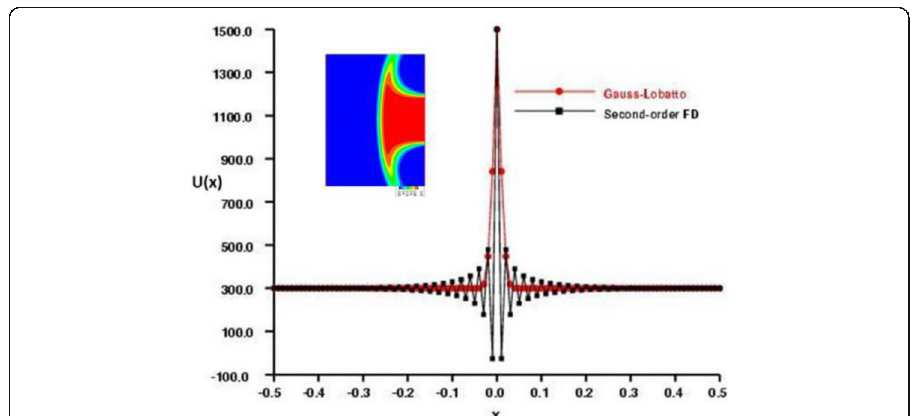
Fig. 6 Refined resolution over flame front by Guass-Lobatto